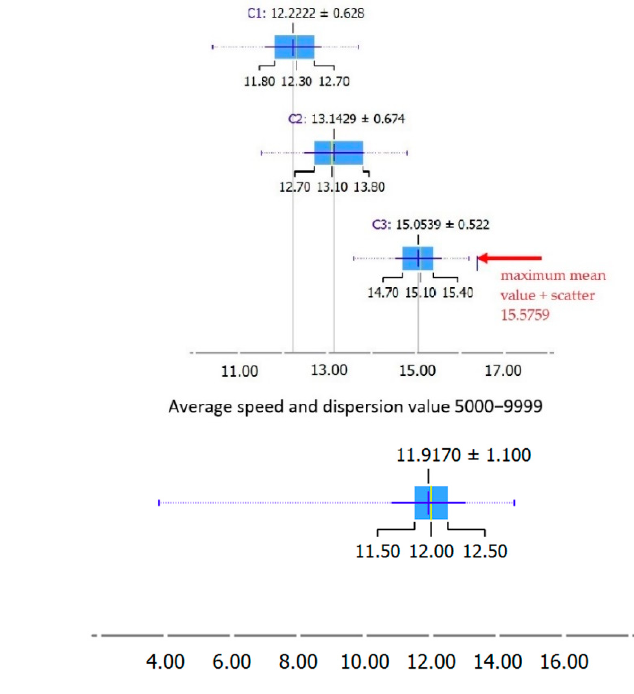
Figure 3. Ship’s speed values (mean value ± scatter). Normalization. The use of neural networks is particularly facilitated if the values of the input data range between 0 and 1. For this reason, a minimum–maximum normalization was performed, and a data set was constructed with the values of all fields in the range of 0.1 using the following Formula (2): 𝑋′ = 𝑋 − 𝑚𝑖𝑛 𝑚𝑎𝑥 − 𝑚𝑖𝑛 (cid:4666)1 − 0(cid:4667) (cid:3397) 𝑚𝑖𝑛 (2) After the completion of the pre-process, data were randomly divided into a training data set (consisting of 80% of the lines) which is used for algorithm training, and validation data set (consisting of the remaining 20% of the lines) for result testing. The power of the main engine was set as a given goal. The following algorithms were used for prediction and are graphically presented in Figure 4: (1) Linear Regression. The linear regression algorithm locates the linear relationship between the dependent variable we are looking for (Y) and one or more independent (X) variables. Since this relationship is linear, we can easily determine how the dependent variable changes with the value of the independent variable [20]. The graphical representation (Figure 4a) of the linear regression operating model is the draw of a sloping and straight line, representing the correlation between independent and dependent variables. The red line represents the prediction that minimizes the overall error. All the predicted values are part of this line and the difference in Y axis between the line and the actual values is the error. (2) Decision Tree. This is a tree-like classifier. It is a structure that is constructed by nodes. There are three different types of nodes: chance nodes, decision nodes, and end nodes. Chance nodes represents the probability of a certain result, decision node represent the decision to be made and the end node shows the result [21]. The tree acts like a map of all possible outcomes for the question asked. Decisions are made based on the characteristics of the data set. It is essentially a graph that aims to